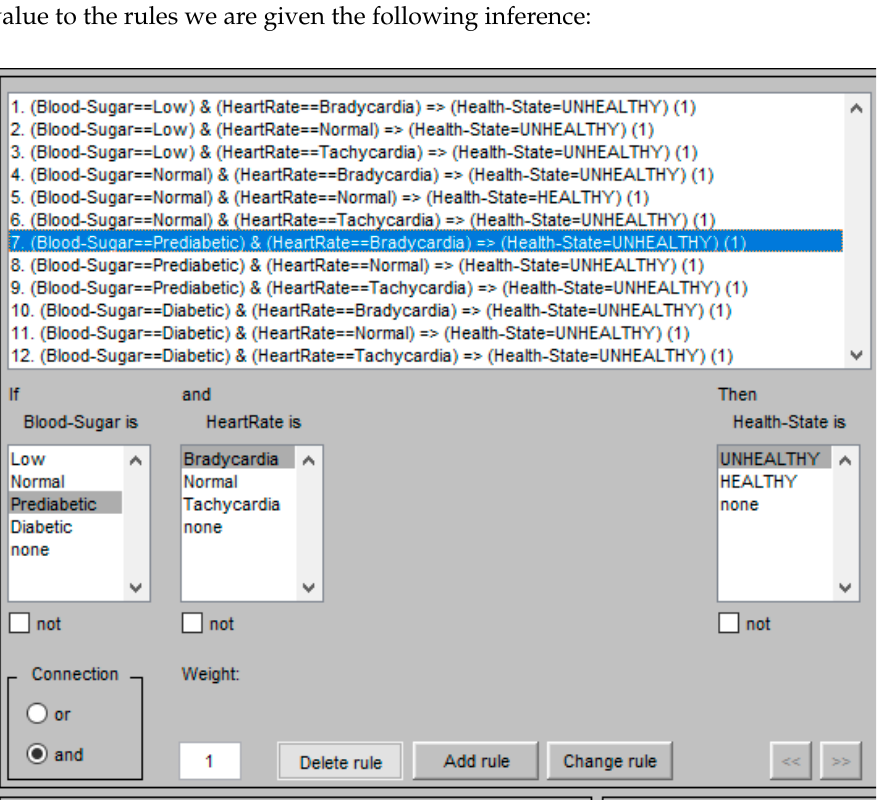
Figure 6. Rules in Matlab Fuzzy Logic Tool to determine the health state. RULE 4: IF Blood sugar == Normal AND Heart rate == Bradycardia then output